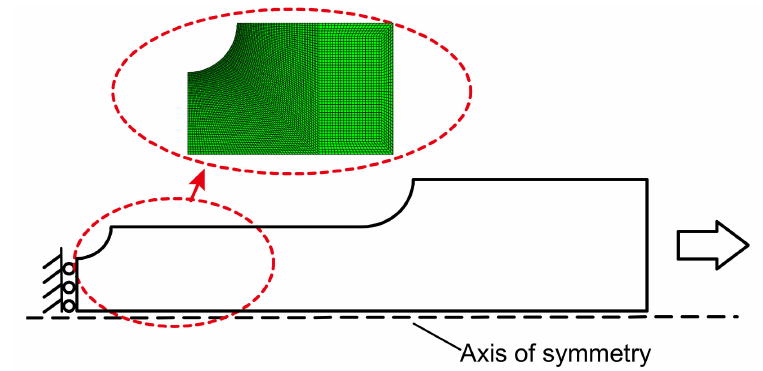
Figure 3. Illustration of the finite element model for the notched specimen.